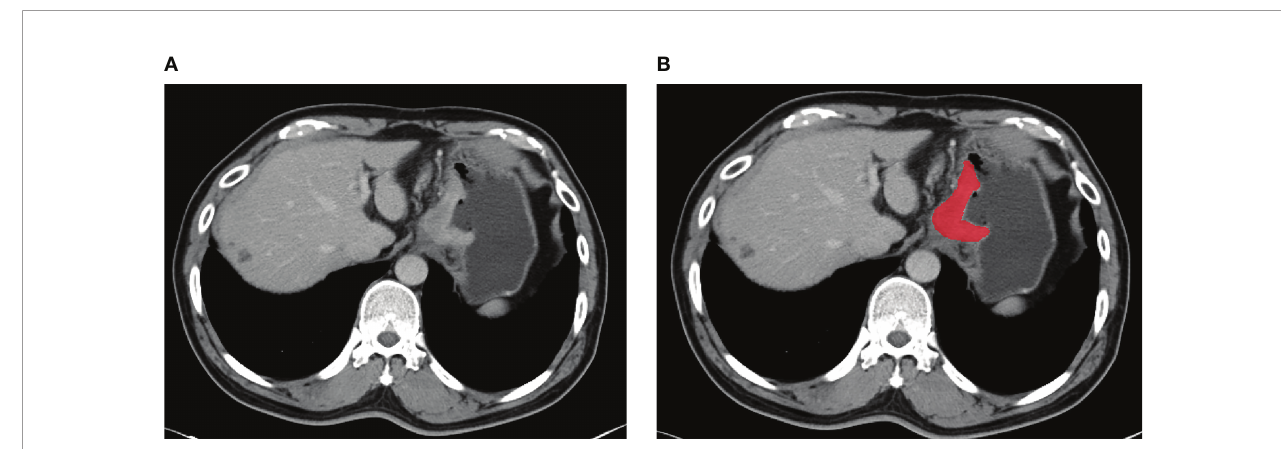
FIGURE 2 | An example of manual segmentation in gastric cancer. (A) Localized thick wall of gastric cancer with enhancement is observed on the portal venous phase computed tomography (CT) image. (B) Manual segmentation on the same axial slice is depicted with red